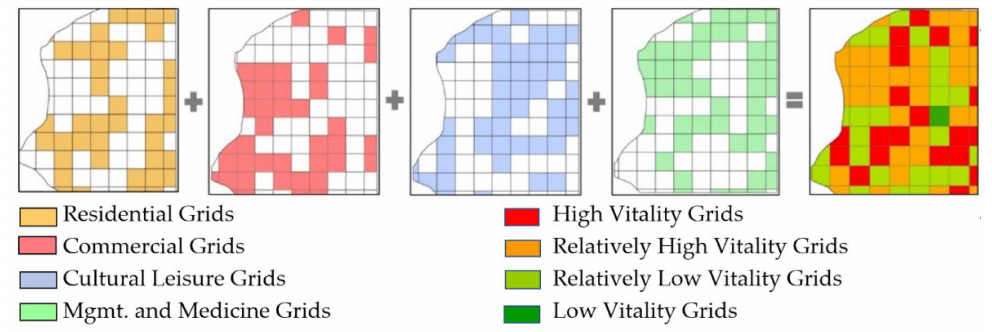
Figure 4. Identification of the type and level of grid vitality based on POI data.